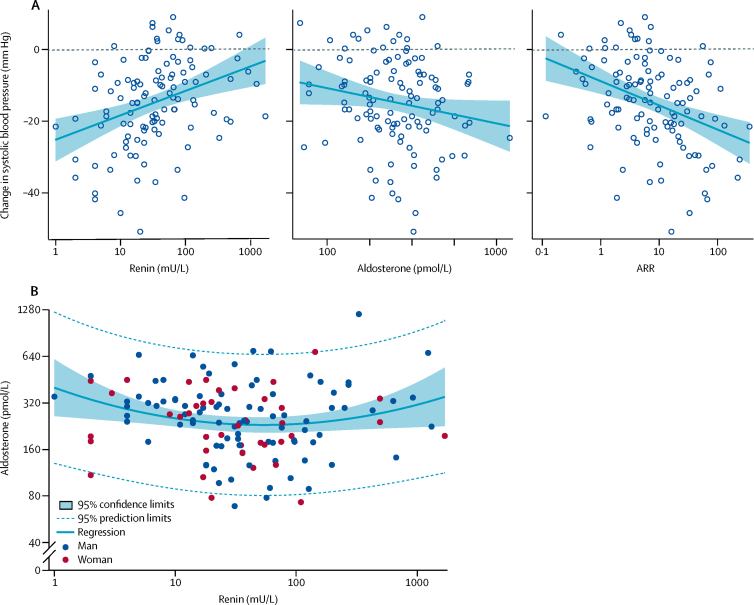
Correlations of plasma aldosterone, renin, and ARR, with blood pressure response to spironolactone averaged (mean) across the 6-week and 12-week visits of each treatment cycle(A) Relation between baseline plasma renin, aldosterone, and the ARR and the home systolic blood pressure response to spironolactone. (B) Best-fit relation between plasma aldosterone and renin concentrations at baseline. Regression equations for change in systolic blood pressure (y): y=(−25·20)+6·86 × (log10renin), r2=0·116 (proportion of variance accounted for by the model); y=8·92–9·85 × (log10aldosterone), r2=0·034; and y=(−8·87)–6·87 × (log10ARR), r2=0·138. Regression equation for aldosterone vs renin: log10aldosterone=2·60–0·279 × (log10renin) + 0·081 × (log10renin)2, r2=0·043. ARR=aldosterone-to-renin ratio.